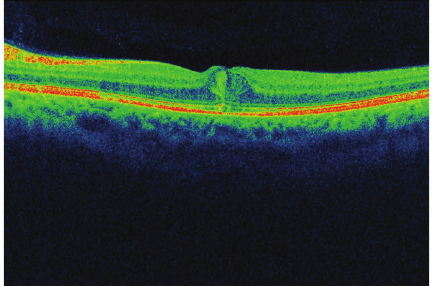
Figure 3: SD-OCT of the patient with T1DM and vitreomacular traction syndrome.